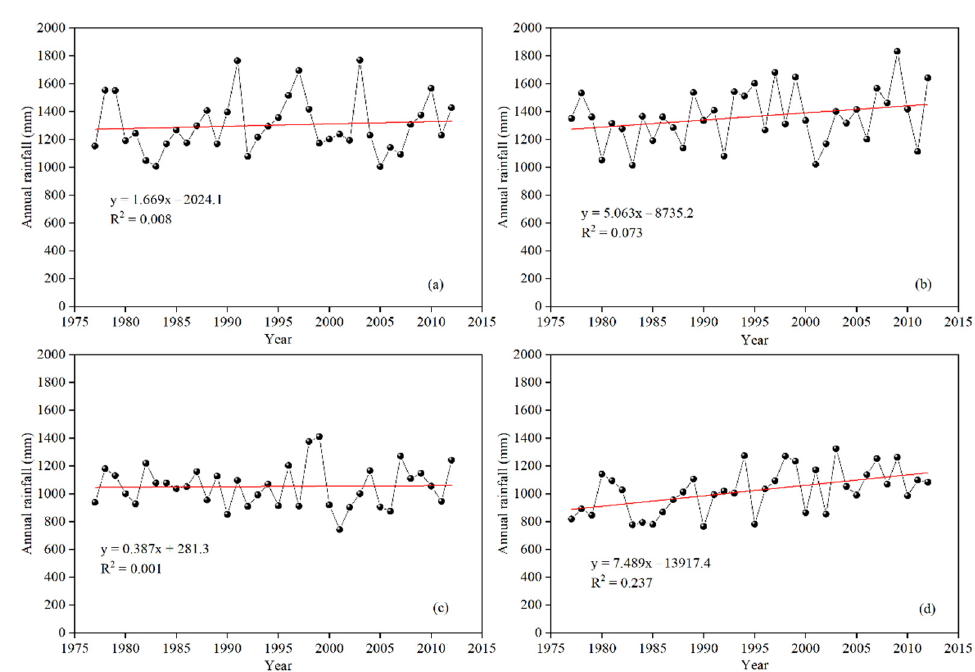
Figure 3. Annual total rainfall at ( a ) Kara, ( b ) Niamtougou, ( c ) Mango and ( d ) Dapaong. At Kara, annual rainfall varied from 1004 to 1771 mm. A non-significant increasing trend ( p > 0.05) in the annual rainfall was observed in Kara (Table 5). The annual rainfall at Niamtougou ranged from 1016 mm in 1983 to 1832 mm in 2009 with a non-significant increasing trend ( p > 0.05). The annual rainfall at Mango fell within the range of 743–1411 mm. A non-significant increasing trend ( p > 0.05) in the annual rainfall was observed at Mango. At Dapaong, mean annual rainfall varied from 765 mm (1990) to 1325 mm (2003) with a significant increasing trend ( p < 0.1) (Table 5). Rainfall in Dapaong was found to have increased (7.79 mm/year) more than the other locations such as Kara (2.20 mm/year), Niamtougou (4.57 mm/year) and Mango (0.67 mm) (Table 5). These findings were corrob- orated by Gadedjisso-Tossou [41] who reported an increasing trend in the long-term an- nual rainfall in northern Togo. Maize and sorghum are particularly vulnerable to water